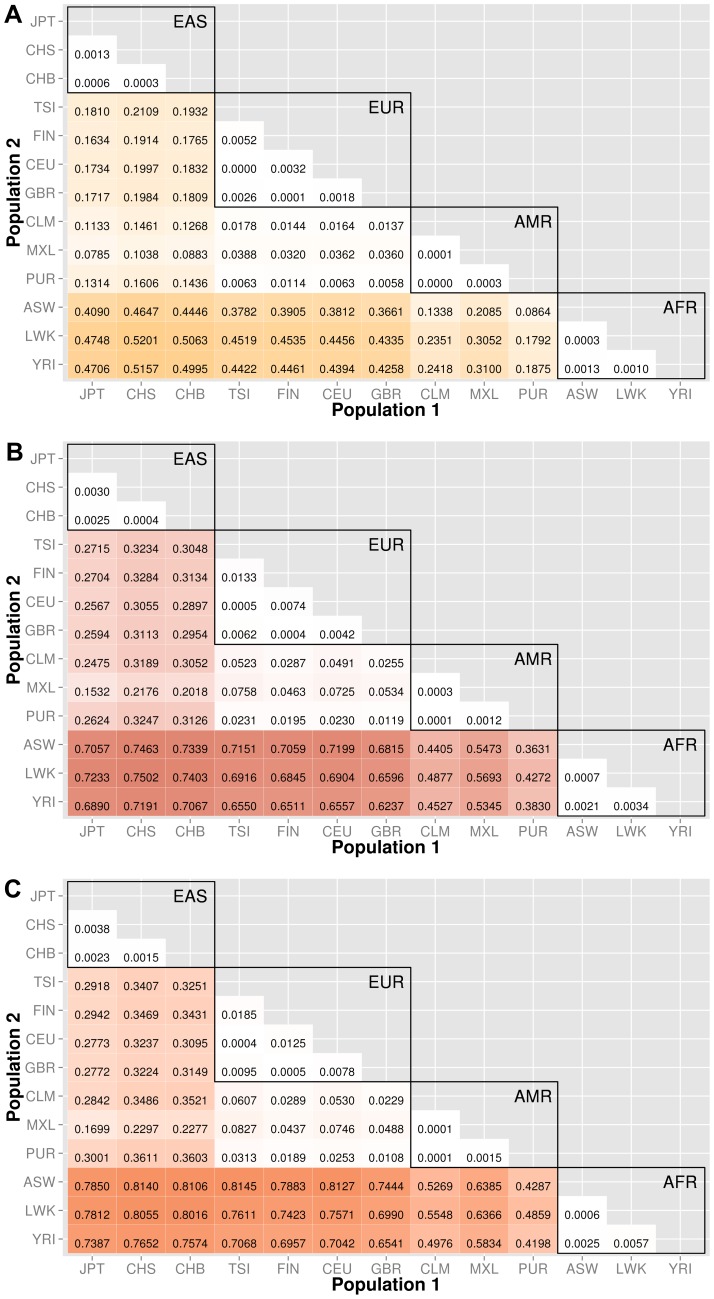
Proportion of significantly different bins in A) gene exon, B) gene intron, and C) intergenic regions.The abbreviations for the each population on found on the x and y-axes. The numbers in each block and the color intensity [0,1] indicate the proportion of significant bins (after Bonferroni correction) for the 1000 Genomes populations on each axis, where the darker the color, the higher the proportion of significant bins. In general, the x-axis is organized with African descent populations on the far right and increasing differentiation with regard to low frequency burden towards the left (i.e. populations of Asian descent have the highest proportion of significant bins compared to African descent groups). The proportion of significant bins across all population comparisons increases from coding (A) to noncoding (B) and finally intergenic (C) regions.